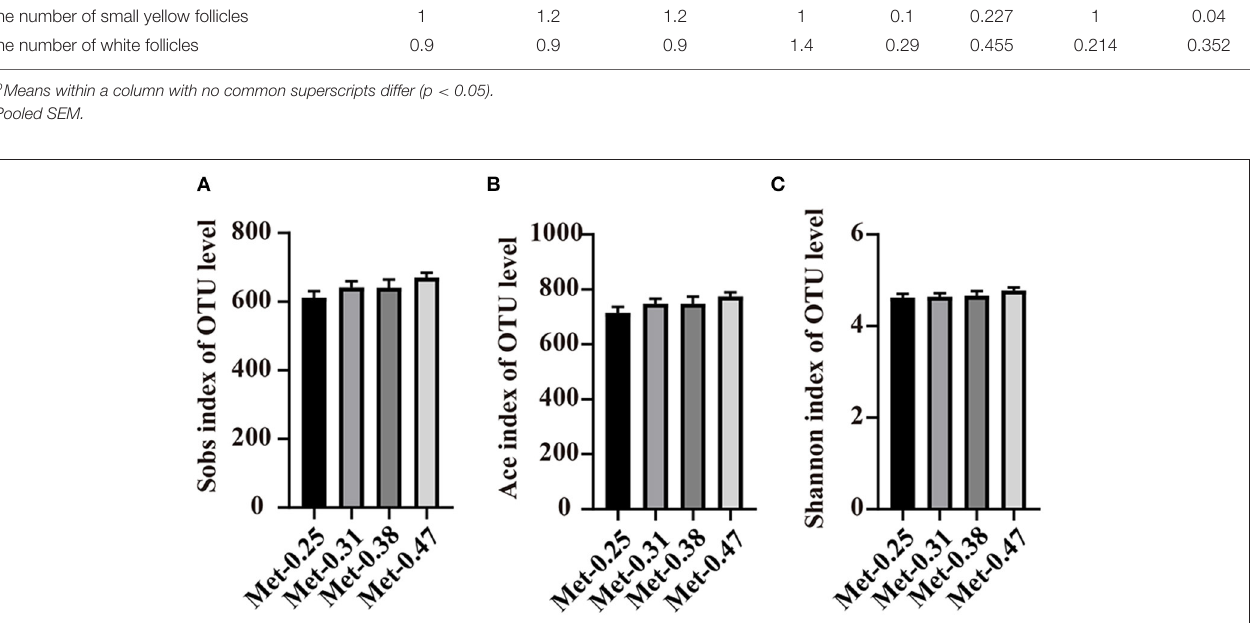
FIGURE 1 | The effects of different dietary methionine (Met) supplementation in low protein diets on the alpha diversity of the cecal microbiota in laying hens. (A) Sobs index of the community diversity. (B) Ace index of the community richness. (C) Shannon index of the community diversity. Data were presented as means ± SEM ( n = 9 per group). Significant differences were tested by a Student’s t